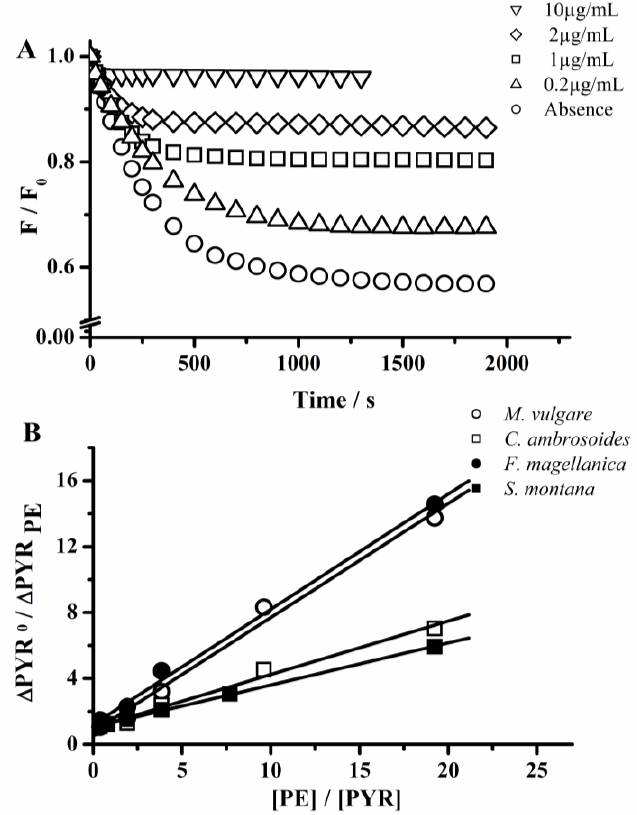
Figure 7. Effect of plant extracts (PE) on the hypochlorite-mediated consumption of PYR. ( A ) Kinetic profiles of the reaction between PYR (5 µM) and hypochlorite (10 µM) in the absence and presence of F. magellanica at 0.2; 1; 2 and 10 µg/mL. ( B ) Dependence of  Probe /  Probe with [PE]/[PYR] ratio. F. magellanica ; M. vulgare ; C. ambrosoides ; 0 PE and S. montana . PE concentrations correspond to µg of dried